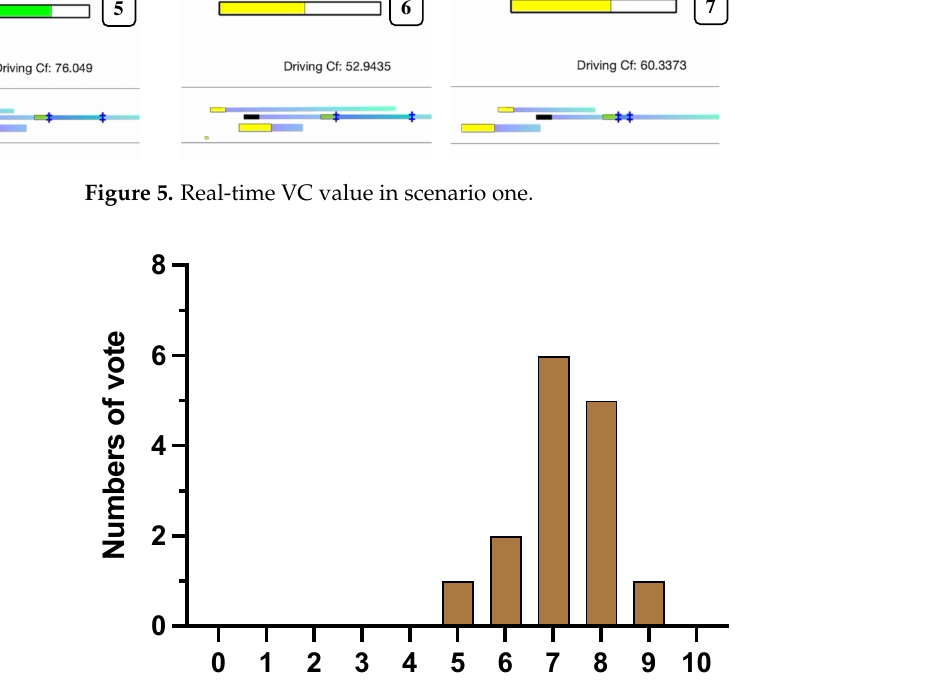
Figure 6. Verification score for scenario